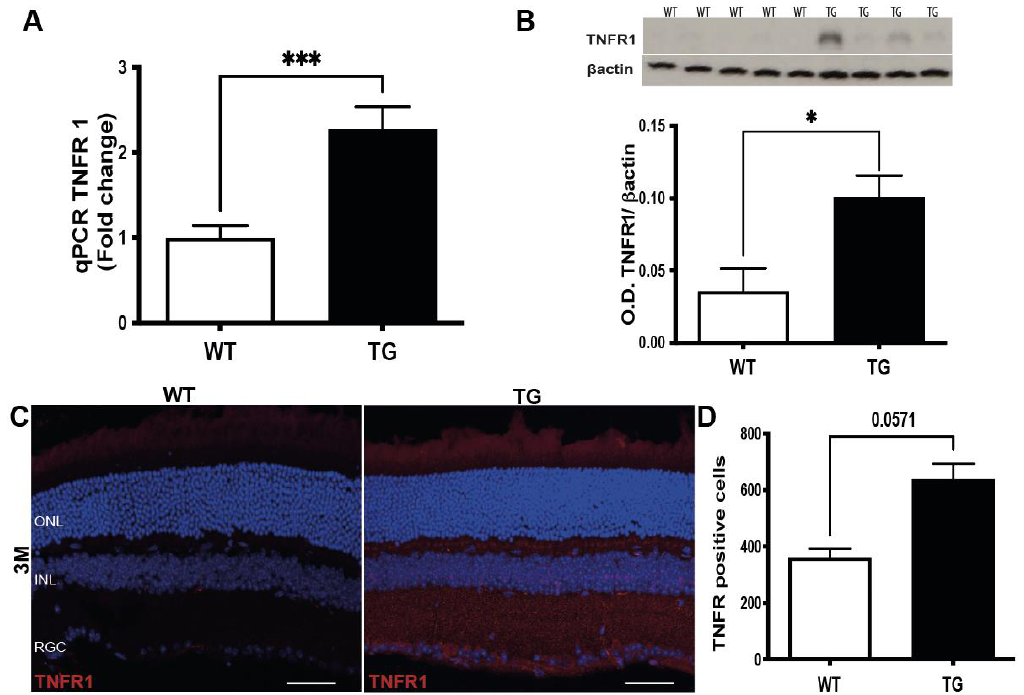
Figure 5. TNFR1 expression in pre-symptomatic APP/PS1 retina. ( A ) qPCR analysis of tnfr1 ex- pression in the retina of TG APP/PS1 versus WT aged 3 months, p = 0.0004 (WT n = 6:3F + 3M; TG n = 9:5F + 4M). ( B ) Representative western blot images and relevant quantification of TNFR1 protein expression in the retina of TG APP/PS1 versus WT aged 3–4 months (WT n = 5:2F + 3M; TG n = 7:4F + 3M). ( C ) Representative image of the TNFR1 localization in the retina layers of TG APP/PS1 versus WT mice aged 3 months. ( D ) Quantification of TNFR1 positive nuclei in the retina of TG APP/PS1mice at 3 months (WT n = 4:4F; TG n = 3:3M). Immunofluorescence experiments: WT (n = 4) and TG APP/PS1 (n = 3) aged 3 months. Results are expressed as mean +/ − SEM. * p < 0.05; *** p < 0.001.